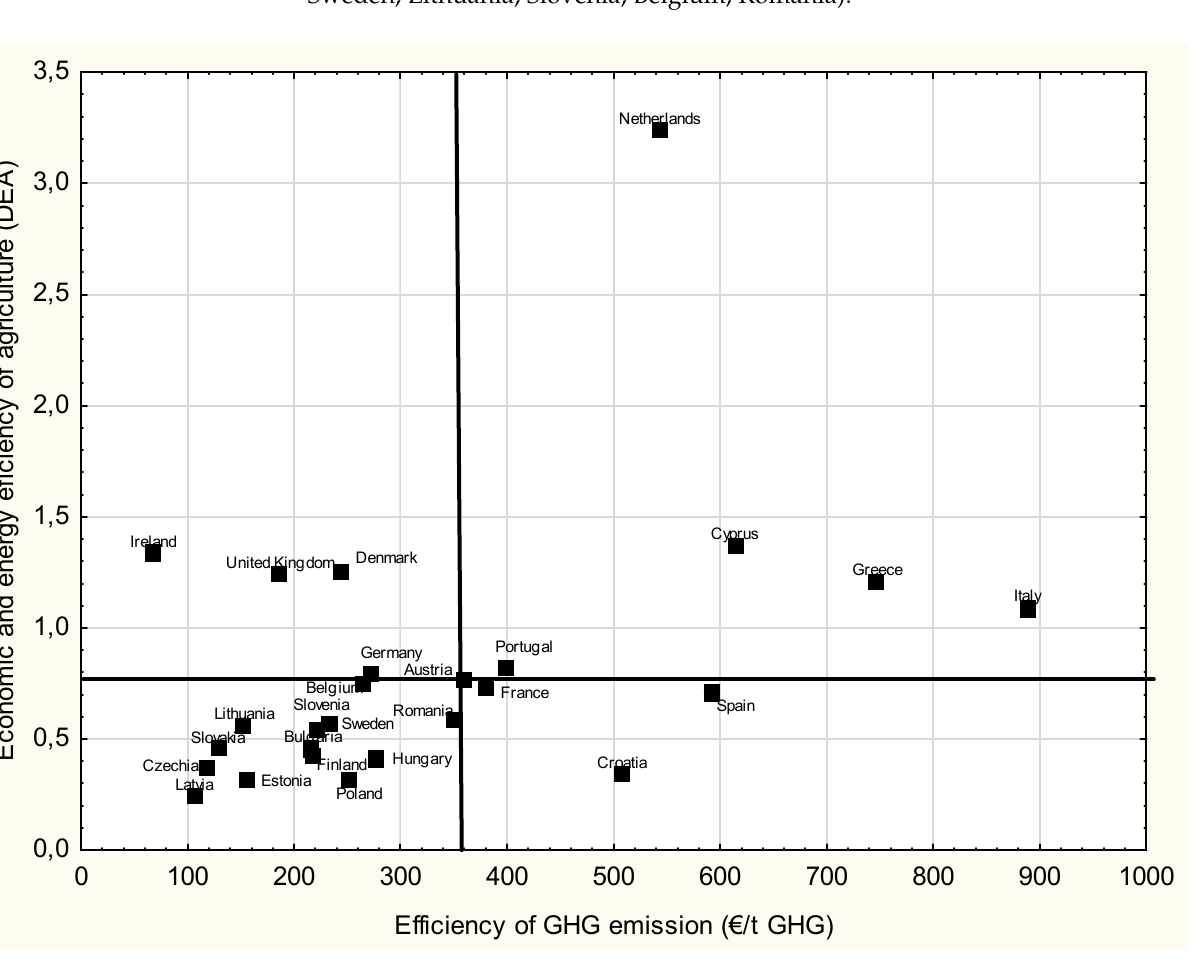
Figure 4. Economic, energy and environmental efficiency of agriculture in EU (2019). Source: author’s own calculations.